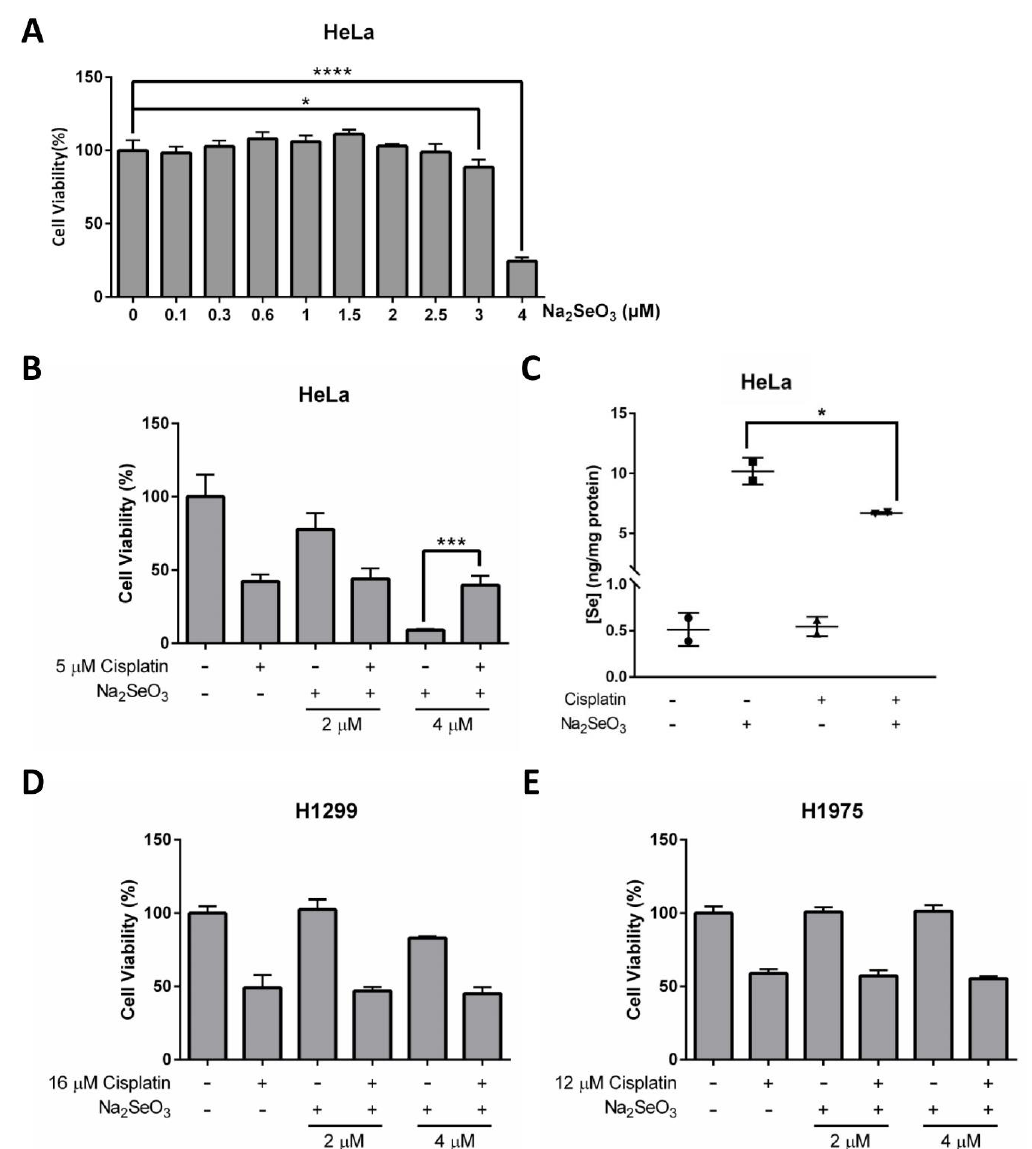
Figure 5. Anticancer effects of Se and cisplatin on HeLa, H1299, and H1975 cells. ( A ) Cell viability of HeLa cells treated with increasing doses of Na 2 SeO 3 for 48 h. ( B ) Cell viability of HeLa cells incubated with 5 µ M cisplatin and/or different doses of Na 2 SeO 3 (2–4 µ M) for 48 h. ( C ) Se concentration in HeLa cells treated with 5 µ M cisplatin and/or 4 µ M Na 2 SeO 3 . ( D , E ) Cell viability of H1299 cells ( D ) and H1975 cells ( E ) incubated with 16 µ M (D) or 12 µ M (E) cisplatin and/or different doses of Na 2 SeO 3 (2–4 µ M) for 48 h. Cell viability was measured by NBB staining assay ( A , B , D , E ), and Se concentration was measured by ICP-MS ( C ). One-way ANOVA ( A – C ) was performed, and a p -value less than 0.05 was considered to be statistically significant. * p < 0.05, *** p < 0.001, **** p < 0.0001.